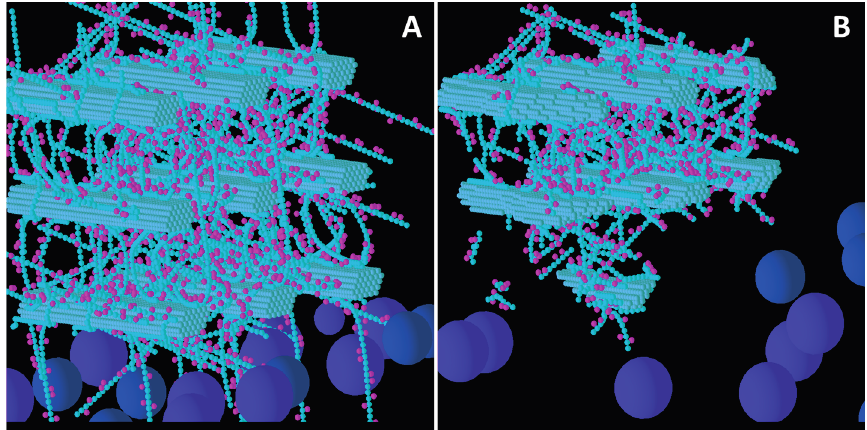
Figure 3. Initial structure of the Medium XG model cell wall ( A ) and the end result of its degradation after a simulation run ( B ). Glucose and xylose are represented by the smaller spheres coloured blue and magenta, respectively. Larger spheres coloured purple and blue represent Cel51A, and Cel9D, respectively. Enzymes shown in pane A are in their original positions, located in the hypothetical biofilm area.